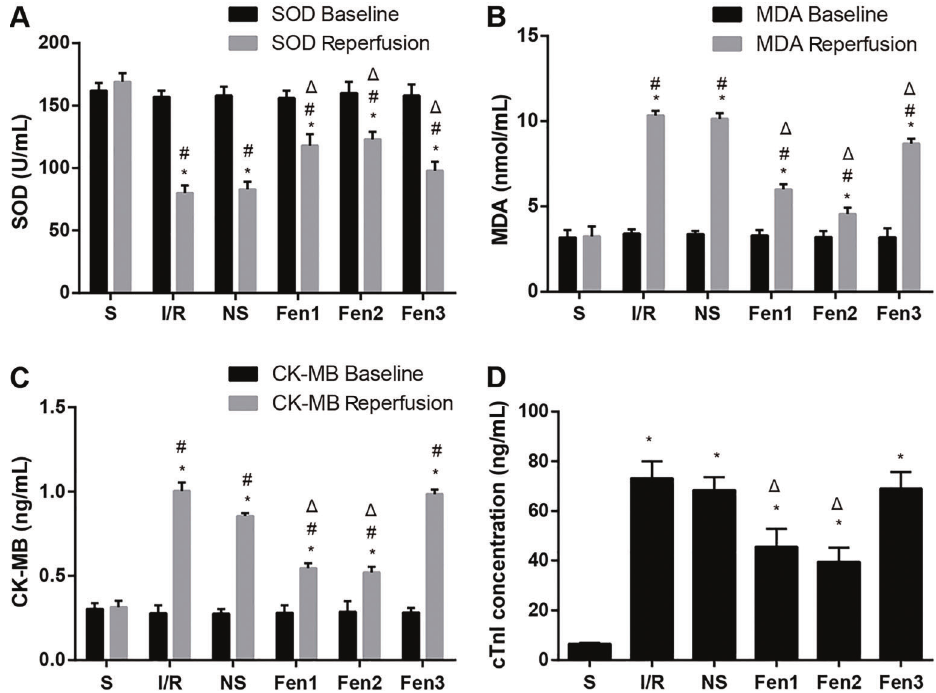
Figure 1. Superoxide dismutase (SOD) ( A ), malondialdehyde (MDA) ( B ), and creatine phosphokinase-MB (CK-MB) ( C ) in the sham operation (S) group, ischemia-reperfusion (I/R) group, normal saline (NS) group, and 2 m g/kg fentanyl (Fen1), 4 m g/kg fentanyl (Fen2), 6 m g/kg fentanyl (Fen3) groups at baseline and reperfusion for 120 min, and serum concentration of cardiac troponin-I (cTnl) ( D ) in each group. *P o 0.05 comparing the SOD, MDA and CK-MB at baseline and reperfusion; # P o 0.05 compared to the S group; D P o 0.05 compared to the I/R group (one-way